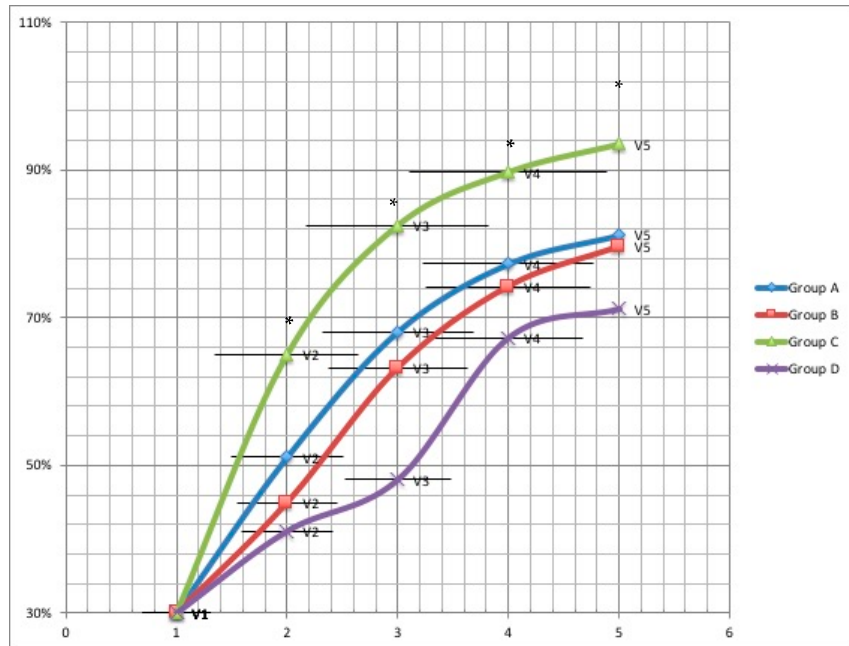
Figure 1. Wound healing rate over time. A significative difference was found between Group C compared to Group D in V2, V3, V5 ( p < 0.01) *. Moreover, the wound healing rate was higher in group C compared to group A and B for all endpoints ( p < 0.01) *.